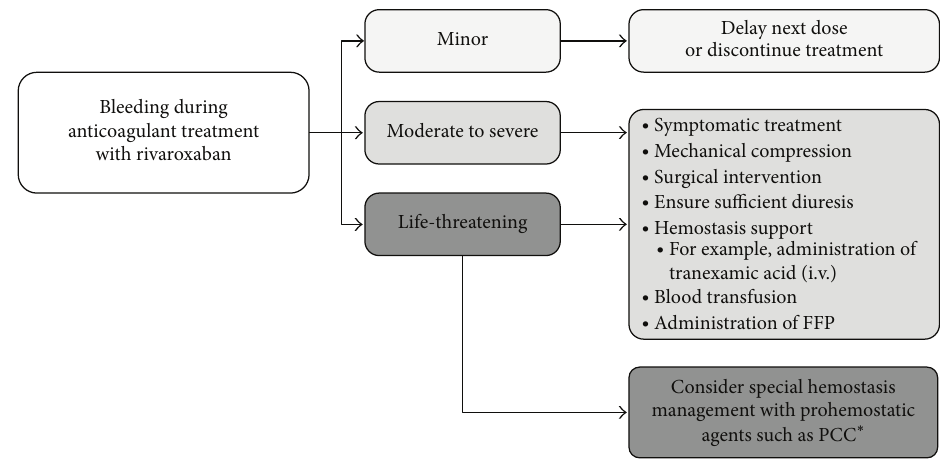
Figure 2: General algorithm for management of bleeding in patients receiving rivaroxaban [2, 31, 33]. ∗ Clinical experience is limited with these agents. FFP = fresh frozen plasma; i.v. = intravenous; PCC = prothrombin complex concentrate.